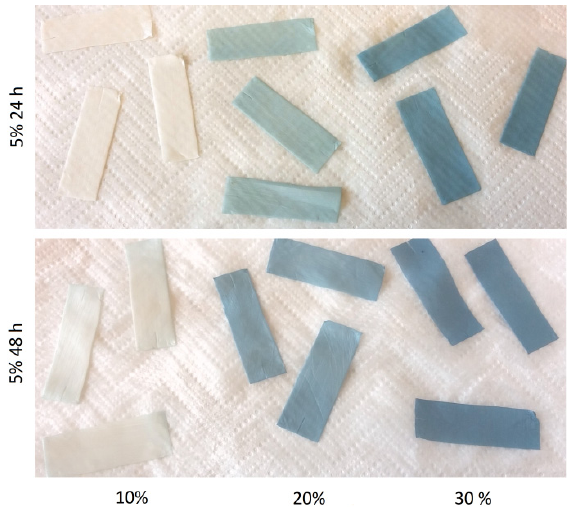
Figure 1. Samples crosslinked with 5% genipin solution for 24 ( up ) and 48 h ( down ) with solvents with increasing water content.